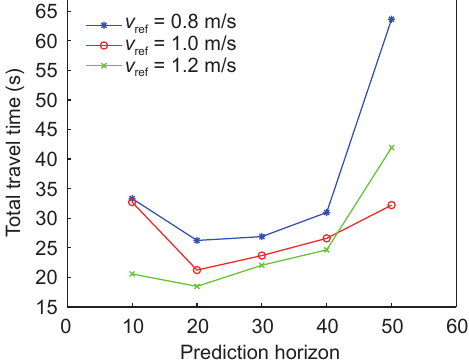
Fig. 8 Comparison of the total travel time under different v and N . ref